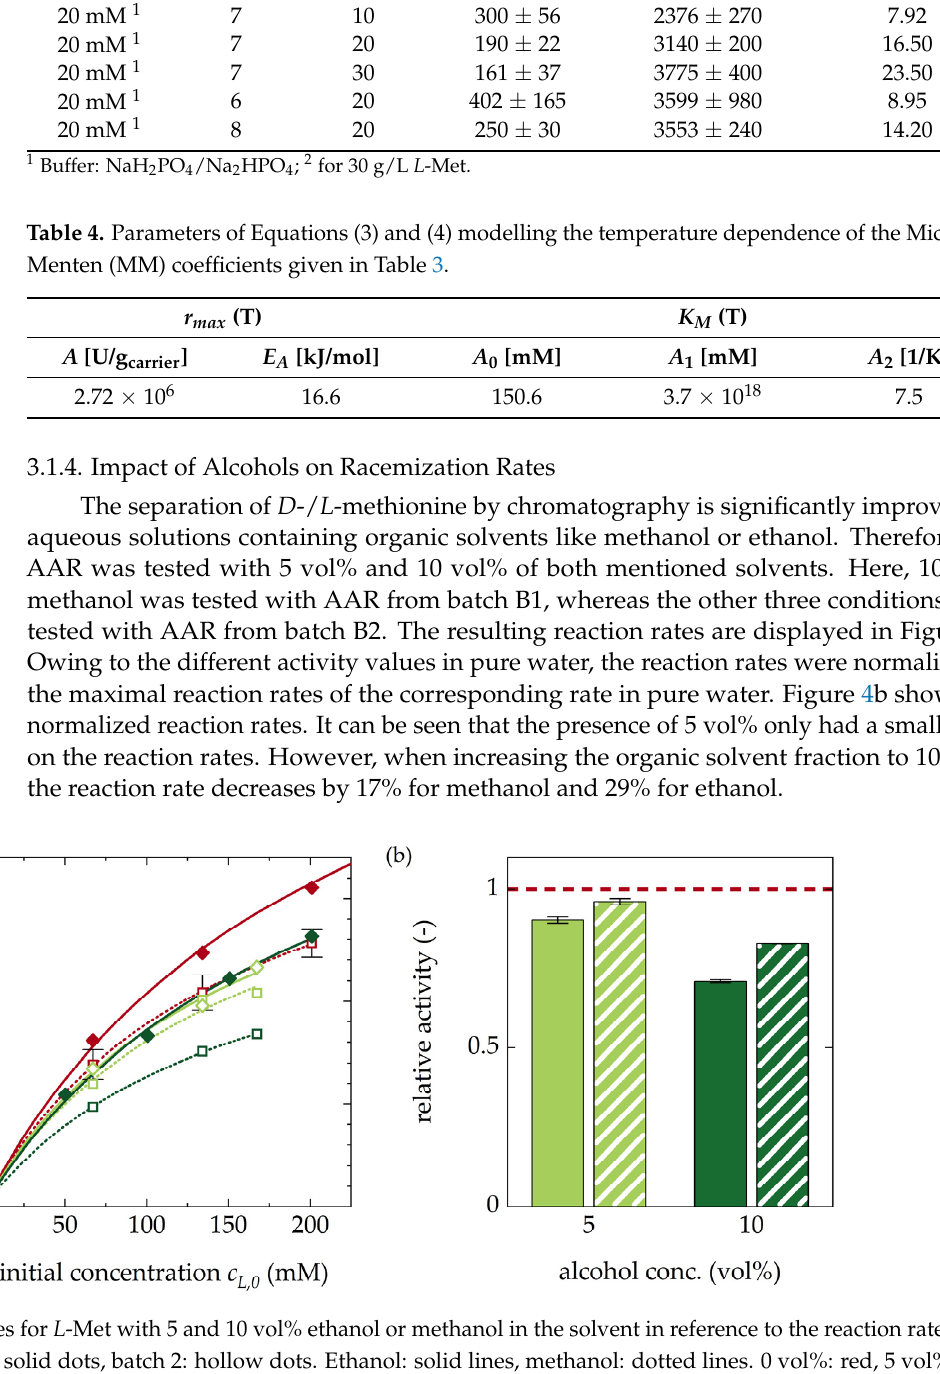
Table 3. Immobilized AAR kinetics in dependence of pH and temperature. Buffer